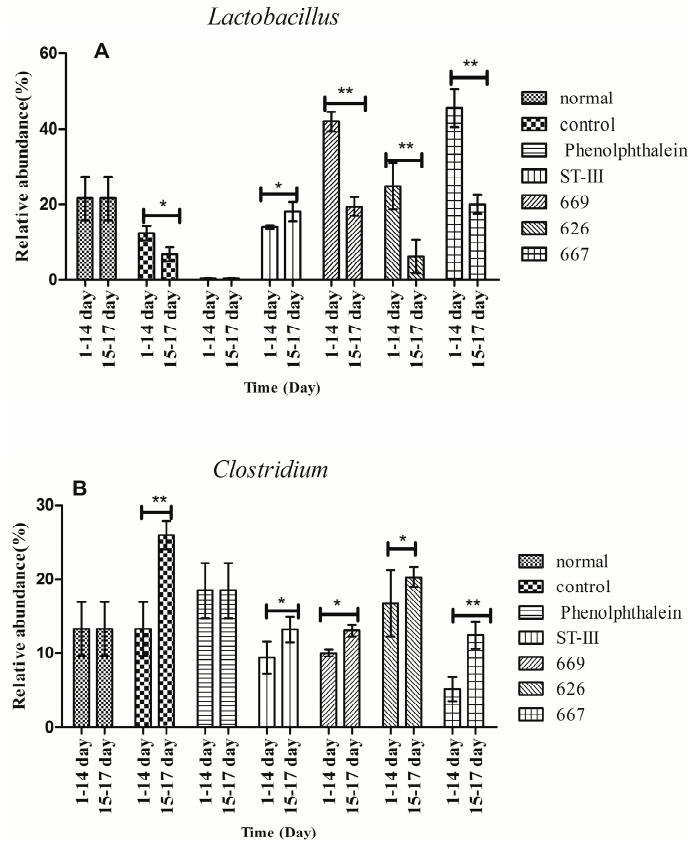
Figure 8. Changes in abundance of selected genera at different periods. * p < 0.05; ** p < 0.01 according to one-way analysis of variance and Duncan’s multiple range test.